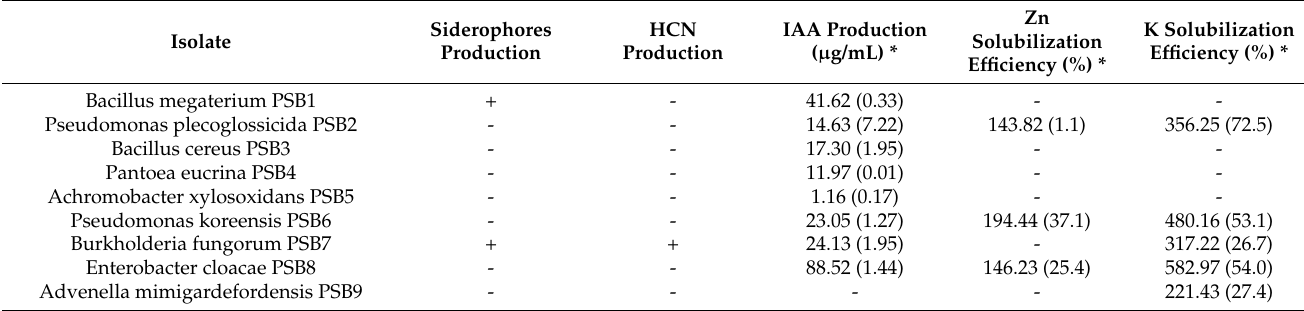
Table 3. Miscellaneous activities of the selected PSB related to PGPR traits including siderophore and HCN production, and ability to solubilize Zn and